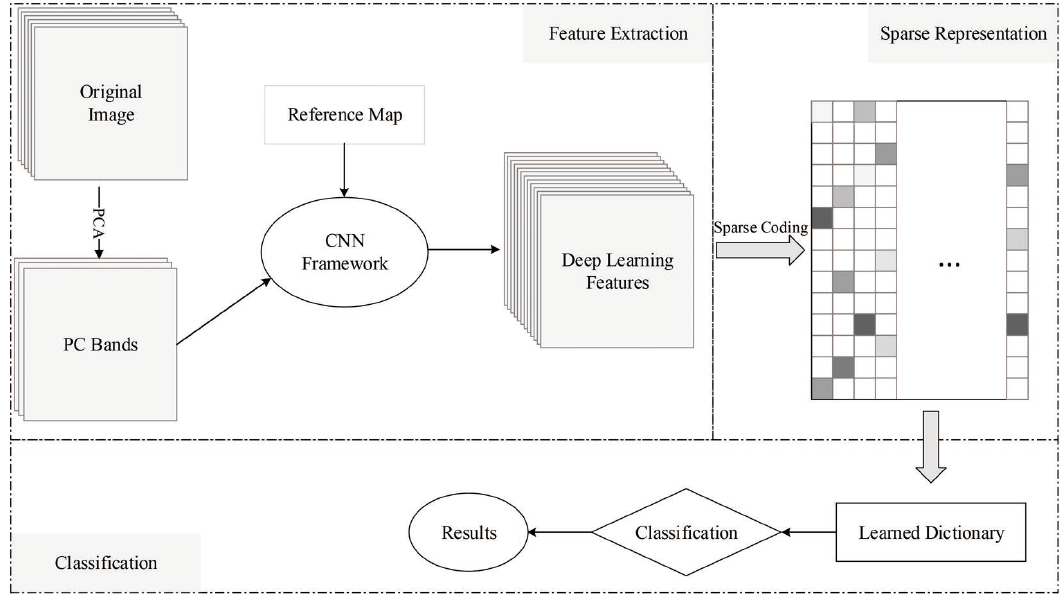
Figure 1. Graphical illustration of the convolutional neural networks (CNN)-based spatial feature extraction, sparse representation and classification of hyperspectral